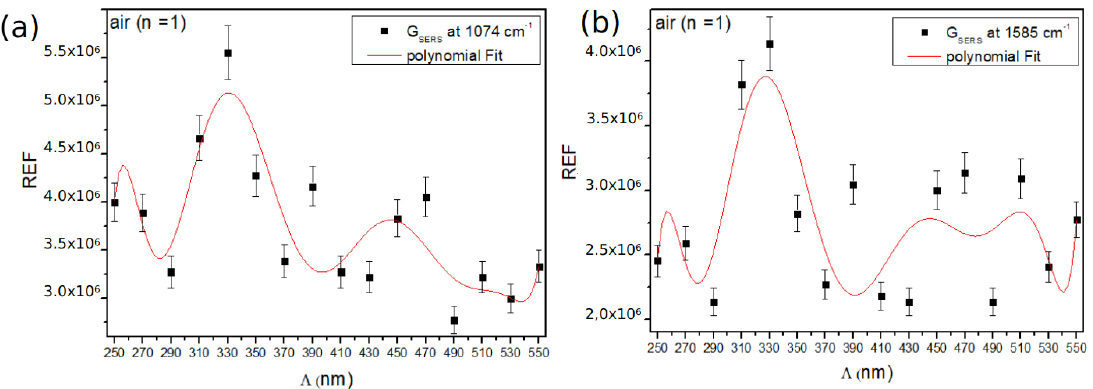
Figure 6. Experimental Raman enhancement factors REF exp as a function of the grating constant for the Raman bands at 1074 cm − 1 ( a ), and 1585 cm − 1 ( b ). Acquisition conditions: excitation wavelength λ exc = 632.8 nm, laser power P = 65 µ W, acquisition time t = 30